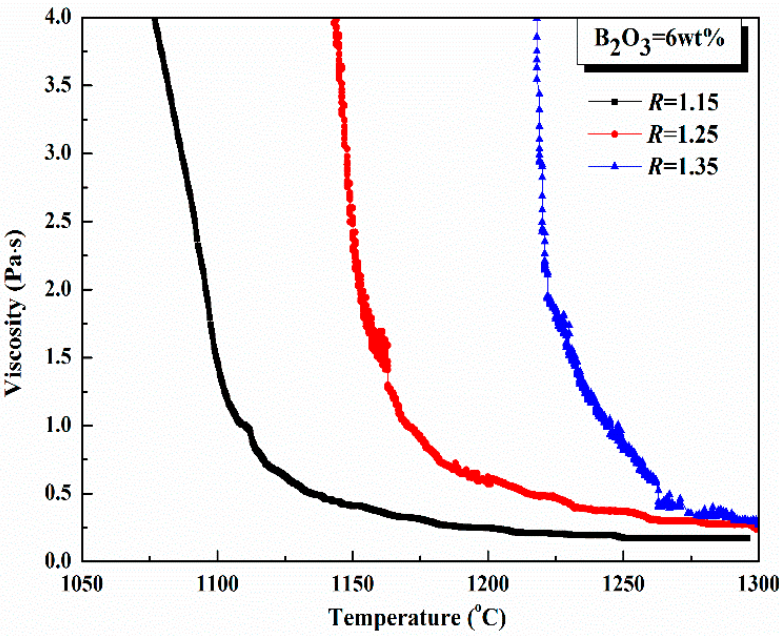
Figure 7. E ff ect of basicity on viscosity-temperature curve of fluorine-free mold Figure 7. Effect of basicity on viscosity-temperature curve of fluorine-free mold flux.